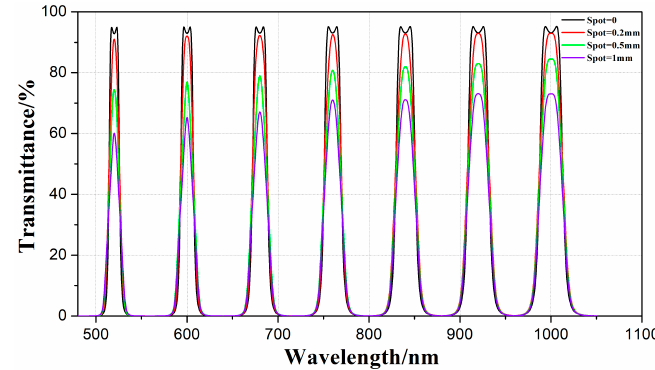
Figure 8. Transmission spectral curves with different sizes of the test spot.